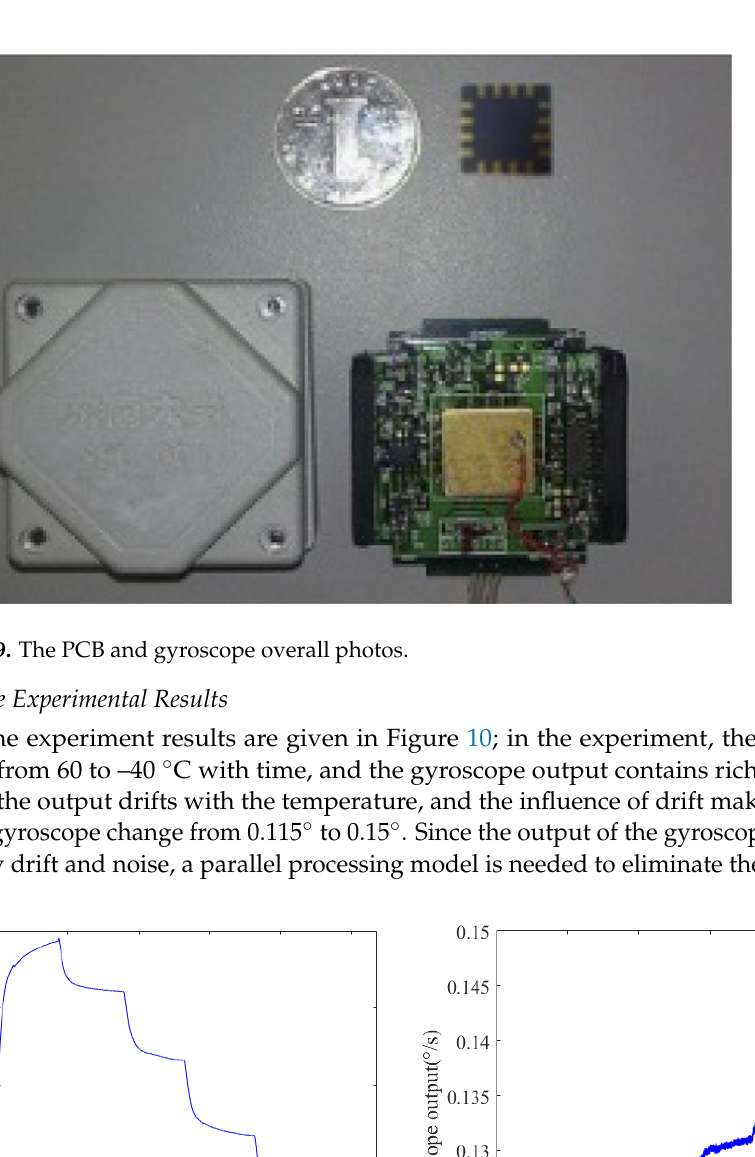
Figure 8. Gyroscope temperature test equipment.